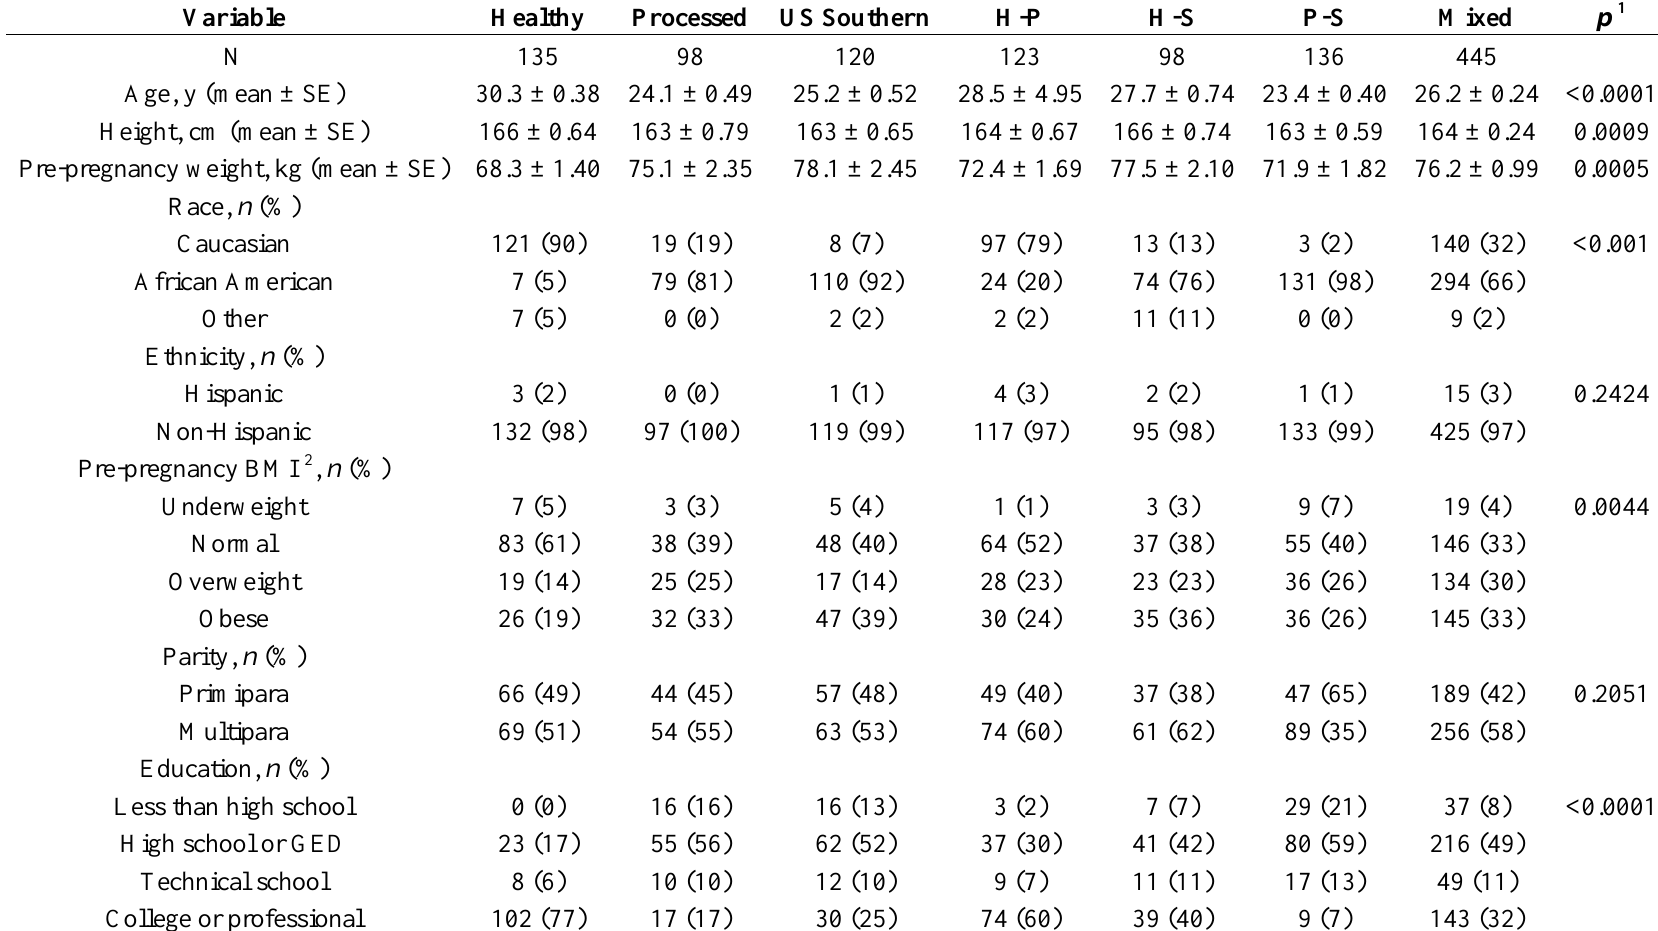
Table 3. Basic characteristics of the study participants by dietary